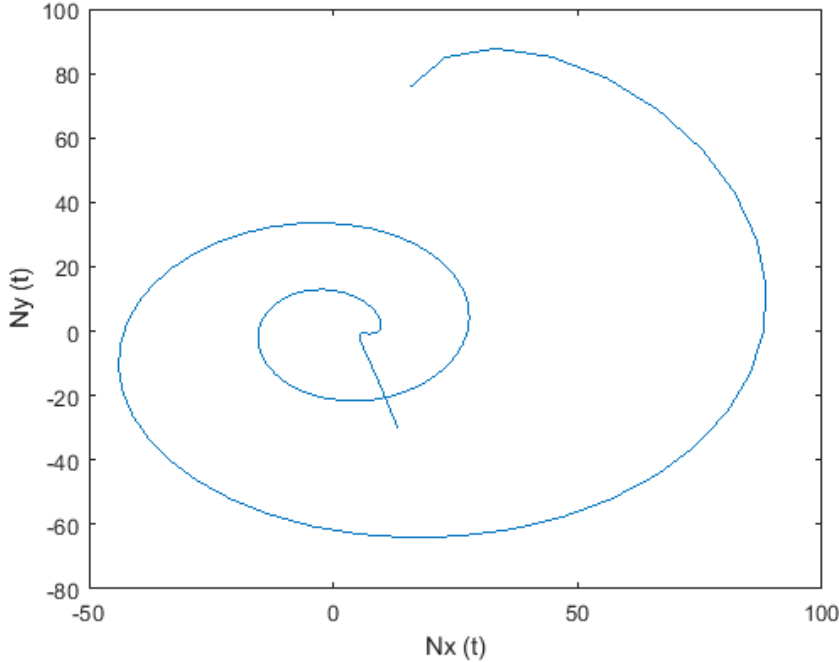
(cid:16) (cid:17) N x vs. N y with parameters: